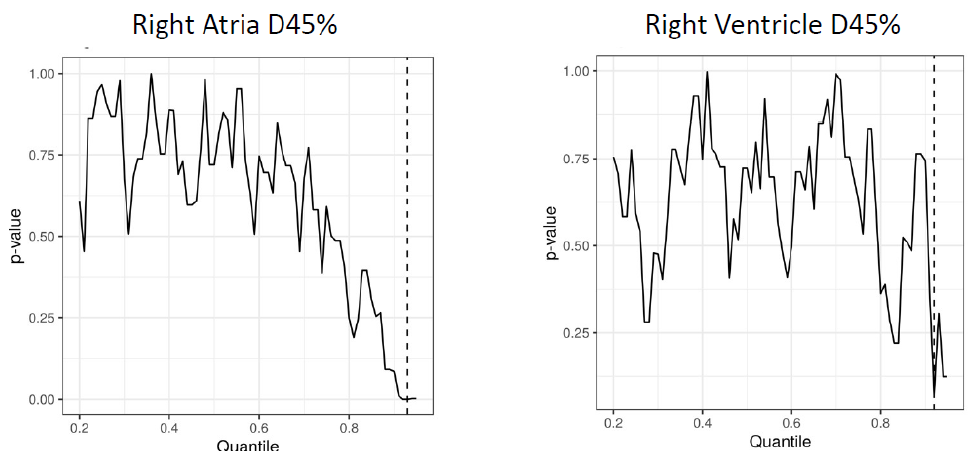
Figure 1. Dichotomization of right atria ( left ) and ventricle ( right ) D45% by observed values between the 20th and 95th percentile and corresponding risk of non-cancer death by log-rank tests. Lowest observed p -value denotes by vertical dashed line.